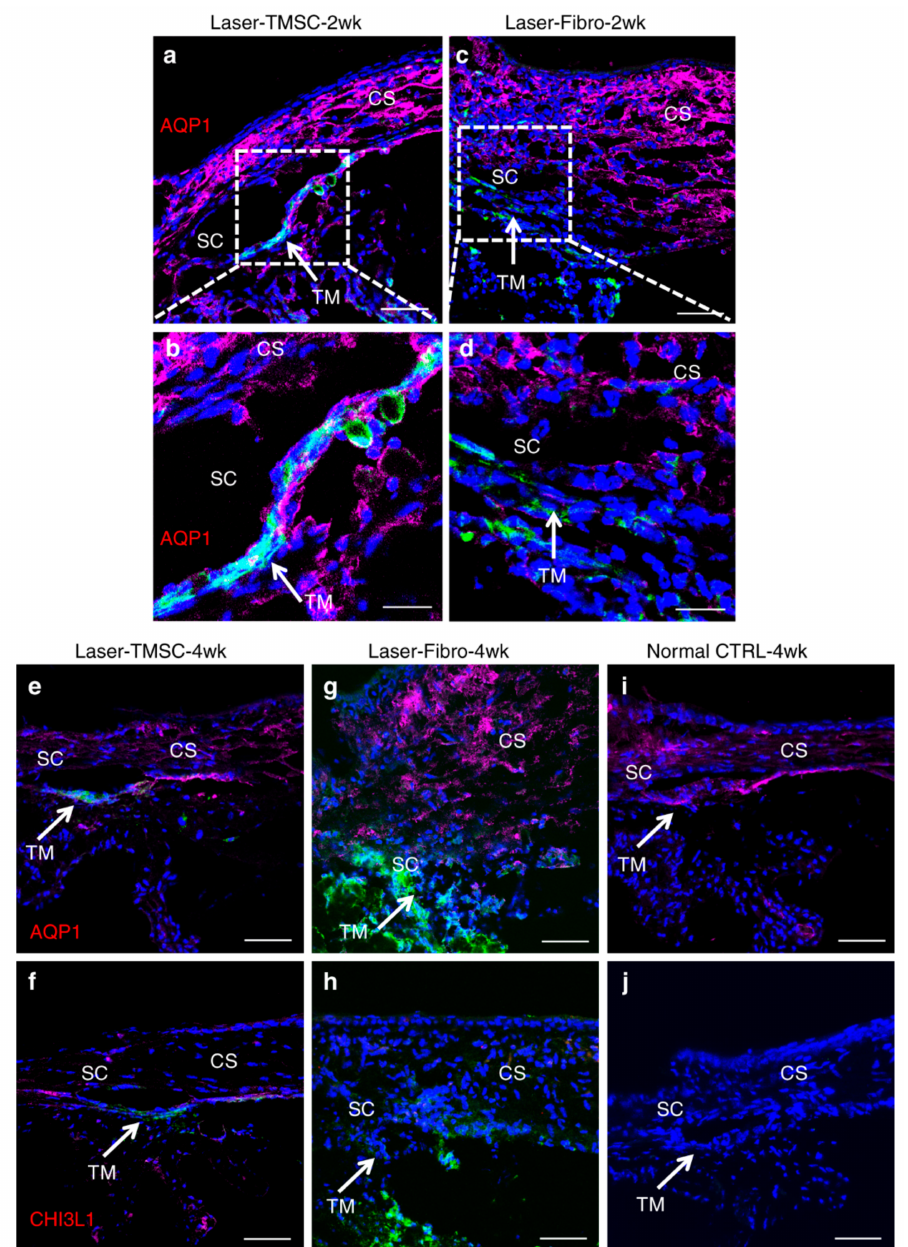
Figure 1. Transplanted TMSCs integrate into the host trabecular meshwork tissue. TMSCs integrated into all layers of the host trabecular meshwork tissue expressing AQP1 ( red ) as indicated by white arrows at 2 weeks after transplantation ( a , b ). Fibroblasts did not integrate into the TM and did not express AQP1 ( c , d ). At 4 weeks after transplantation, TMSCs integrated into the TM and expressed AQP1 ( e ) and CHI3L1 ( f ). Fibroblasts did not express AQP1 ( g ) or CHI3L1 ( h ). In non-treated mouse tissue, trabecular meshwork cells, endothelial cells, and keratocytes expressed AQP1 ( i ), whereas none of these mouse cells expressed CHI3L1 ( j ) ( note: anti-CHI3L1 is a human-specific antibody and anti-AQP1 antibody recognizes both human and mouse antigens). Arrows point to the TM. Green indicates DiO-labeled ( injected ) cells. Scale bars, 50 µ m ( a , c , e – j ); 20 µ m ( b , d ). TM trabecular meshwork, SC Schlemm’s canal, CS corneal stroma. Adapted from Yun, H., et al. Commun Biol 1, 216 (2018) under the Creative Commons Attribution 4.0 International (CCBY4.0)